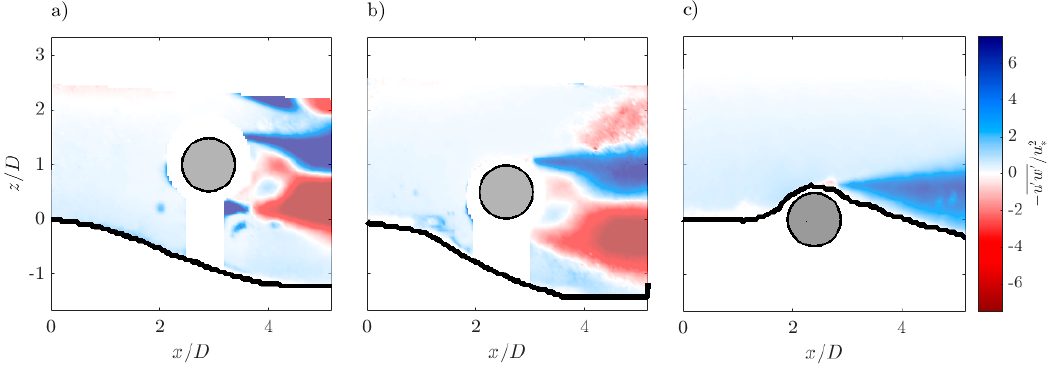
Figure 10. Dimensionless Reynolds shear stresses on a vertical plane in ( a ) Run 1, ( b ) Run 2 and ( c ) Run 3.